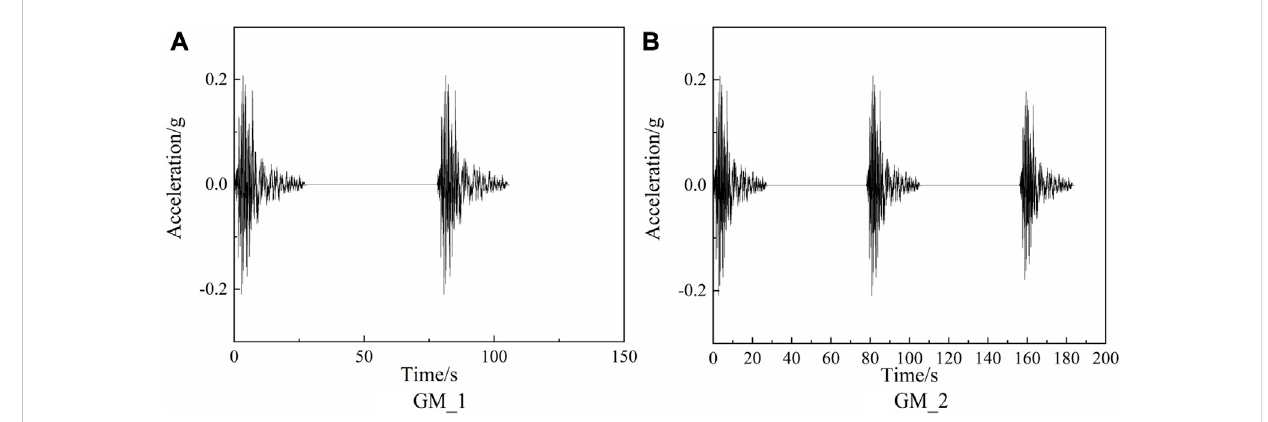
FIGURE 5 xample of acceleration time history of main-aftershock